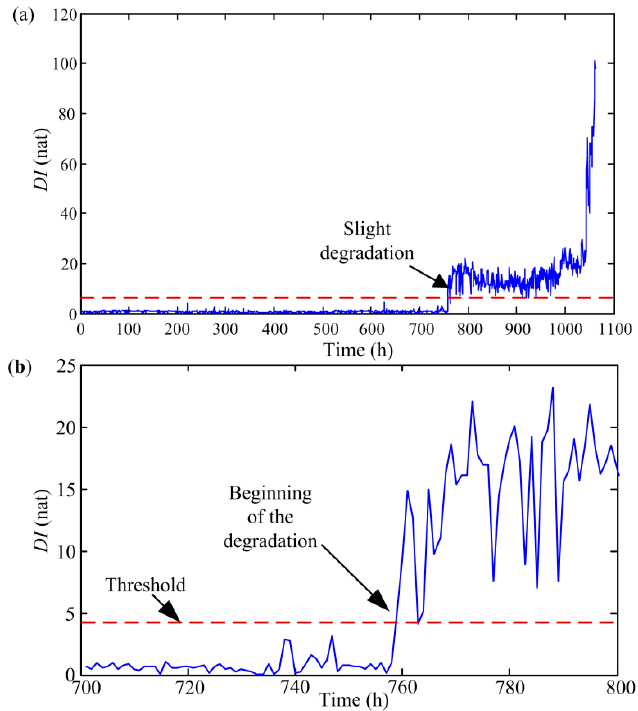
Figure 4. DI sequences of the aviation pump based on GMM: ( a ) full life cycle and ( b ) partial enlargement drawing.